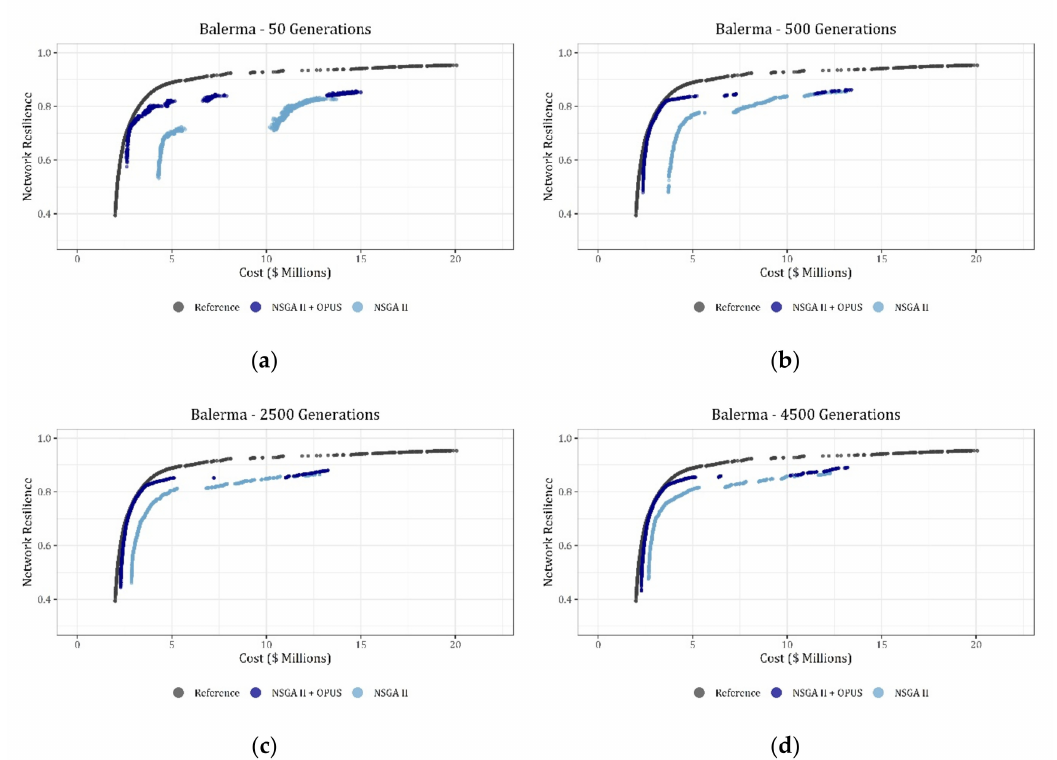
Figure 5. Evolution of the PFs for the NSGA-II algorithm (light blue) and the retrofitted NSGA-II with OPUS (dark blue) in comparison to the best-known PF (black) for Balerma. ( a ) 50 generations; ( b ) 500 generations; ( c ) 2500 generations and ( d ) 4500